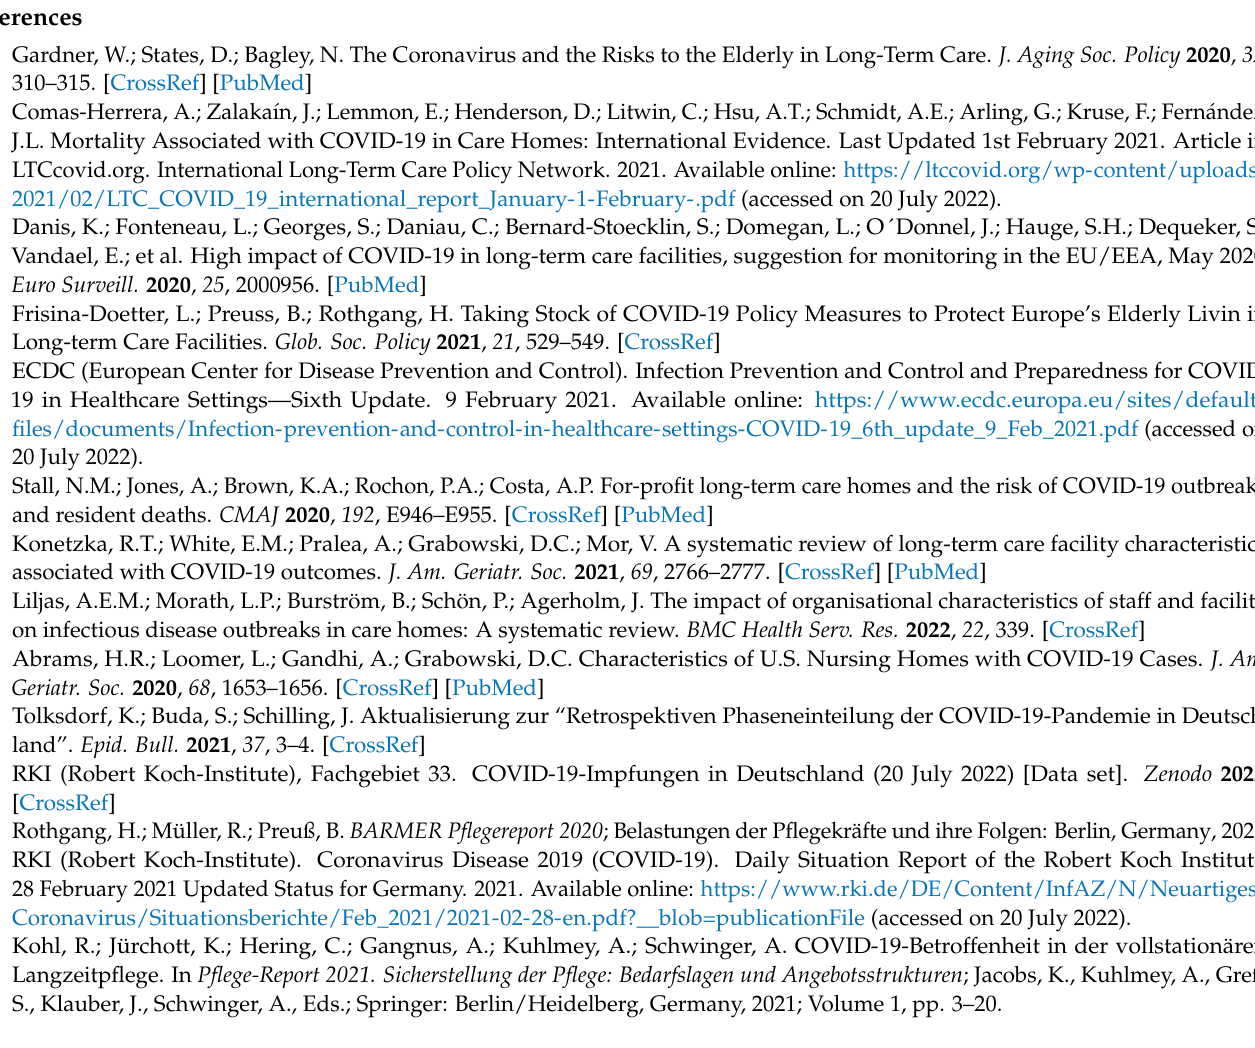
Figure A2. Plotting the logarithmic frequency of observing no outbreak against the facility size in the second wave.